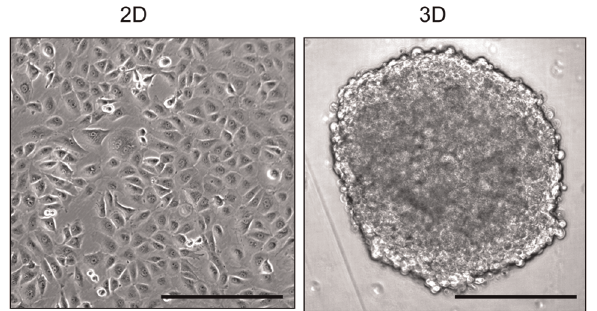
Figure 1. The exvivo tumor spheroid model. Microscopic images of monolayers and spheroids of human mesotheliomoa cell line NCI- H226. 2D: monolayers; 3D: spheroids. Scale: 400 m m.